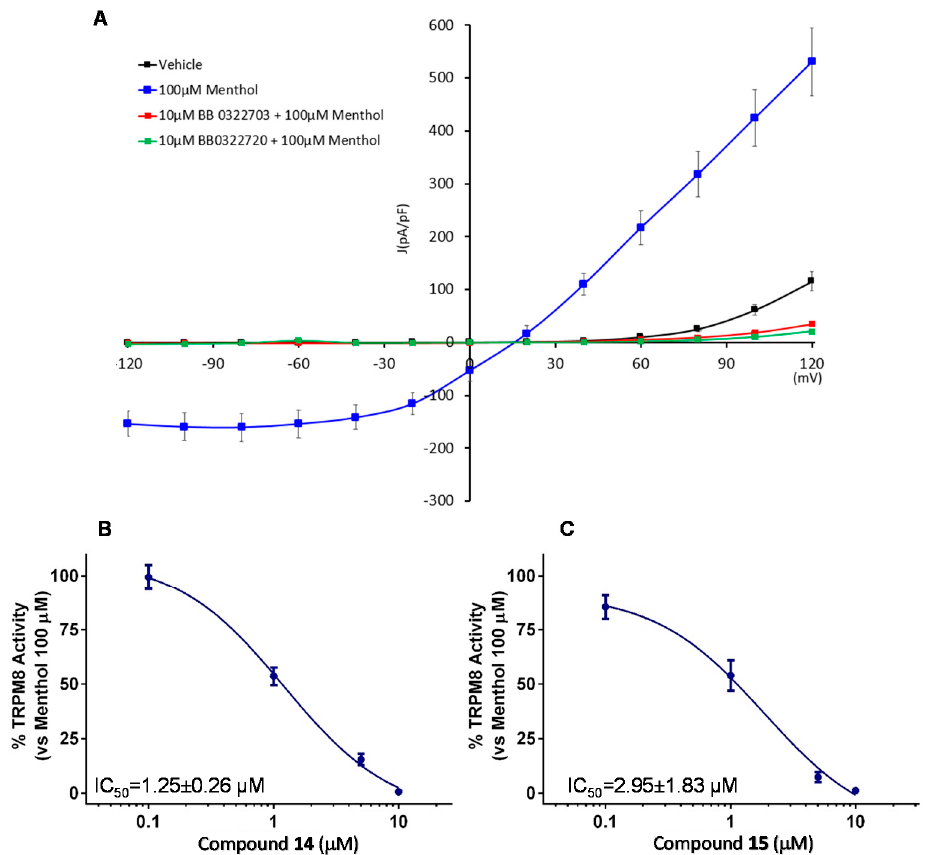
Figure 6. Compounds 14 and 15 ( BB 0322703 and BB 0322720 , respectively) blocks TRPM8-mediated responses evoked by menthol in rTRPM8-expressing HEK293 cells ( A ) Curves obtained after: exposure to vehicle solution (black trace) 100 µ M menthol (blue trace), 100 µ M menthol + 10 µ M 14 (BB 0322703) (red trace), and 100 µ M menthol + 10 µ M 15 (BB 0322720) (green trace). Peak current data were expressed as pA/pF (to allow comparison among different size cells). Each point is the mean ± SEM of n = 15. ( B ) Dose-response curve for the inhibitory effect over the currents evoked by 100 µ M menthol in HEK293 cells expressing TRPM8 by compound 15 ( BB 0322720 ). ( C ) Dose-response curve for the inhibitory effect over the currents evoked by 100 µ M menthol in HEK293 cells expressing TRPM8 by compound 14 ( BB 0322703 ). The solid line represents fits of the experimental data to the following equation: Y = Bottom + (Top − Bottom)/(1 + 10 ((LogEC50-X) × HillSlope) ), with the restriction of the minimum (Top = 100) IC 50 = 1.25 (1.00–1.56) µ M with r 2 = 0.99 and Hill slope = − 1.23 for 14 ( BB 0322703 ) and IC 50 = 2.95 (0.82–10.61) µ M with r 2 = 0.97 and Hill slope = − 0.71 for 15 ( BB 0322720 ) Each point is the mean ± SEM of n = 15 .